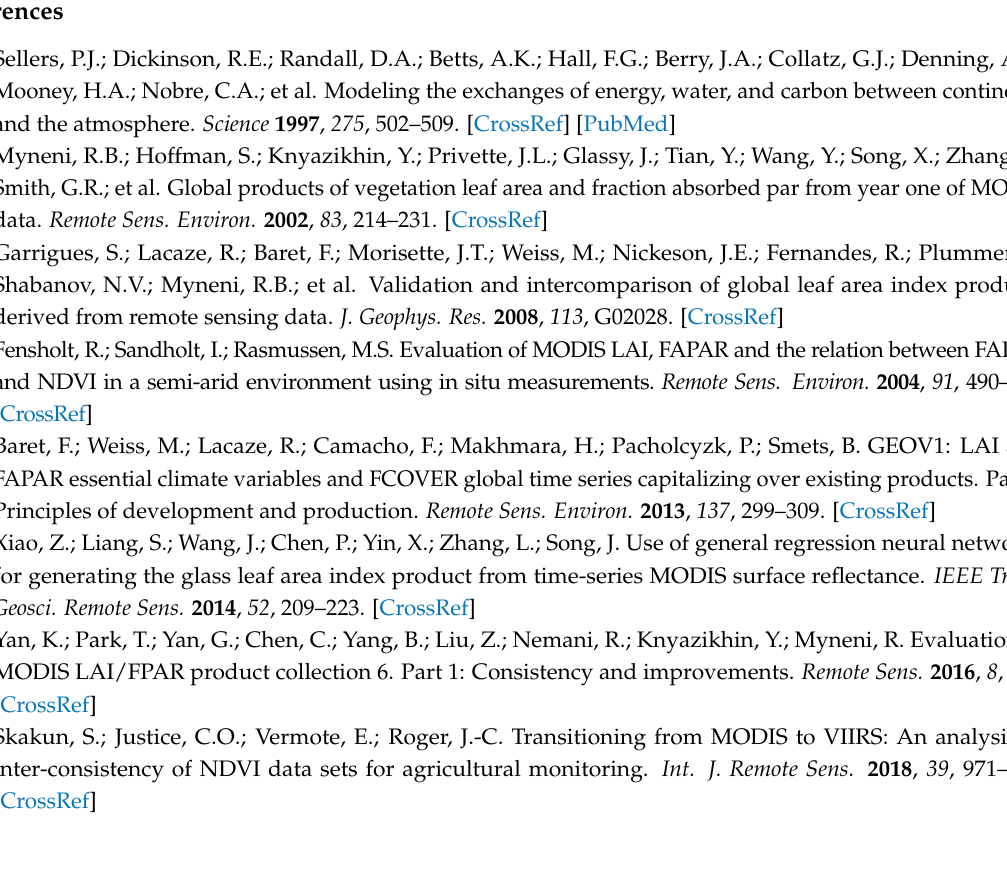
Figure S1: Global land cover map used in this study, Figure S2: The quality control based on “FparLai_QC” and “FparExtra_QC” layers for VIIRS and MODIS products under study, Table S1: Characteristics of the available ground sites and aggregated LAI_effective/LAI_true/FPAR values over 3 km × 3 km area, Figure S3: Spatial distribution of the BELMANIP-2.1 network and ground measurements for VIIRS LAI/FPAR product assessment, Table S2: The mean and standard deviation of LAI/FPAR difference between VIIRS and MODIS products (VIIRS-MODIS) at seasonal scale for each biome type from 2012 to 2016, Figure S4: The examples for the comparison between VIIRS and MODIS products at the native spatiotemporal (500-m/8-day) resolution, Figure S5: The annual variation of global retrieval rate of different algorithm paths for eight biome types (B1–B8 are same as in Figure S1), Figure S6: The annual variation of mean difference of retrieval index (DRI, calculated from VIIRS-MODIS) for non-forest and forest biomes in January and July from 2012 to